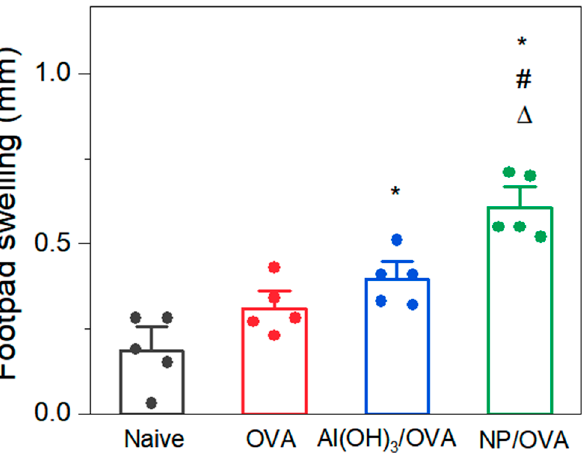
Figure 6. Delayed-type hypersensitivity reaction assessed as the mean footpad swelling ± standard deviation of animals immunized with ovalbumin (OVA), Al(OH) 3 /OVA or PMMA/DODAB/OVA (NP/OVA). p < 0.05 compared to the naive group (*), p < 0.05 compared to the OVA group (#), p < 0.05 compared to the Al(OH) 3 /OVA group ( ∆ ).